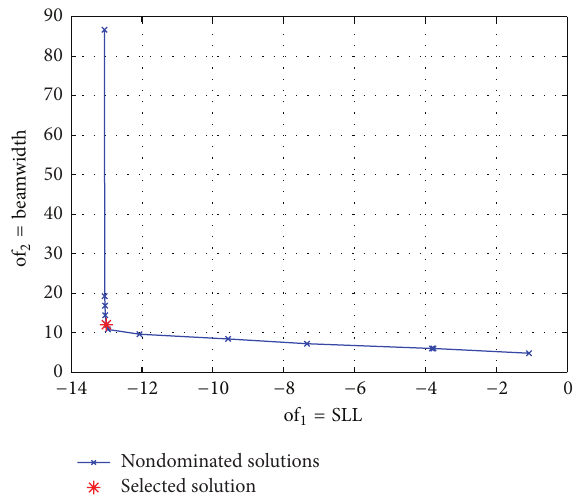
Figure 3: Nondominated front obtained by DEMO/parent algo- rithm and the selected solution for steerable energy pattern of a circular antenna